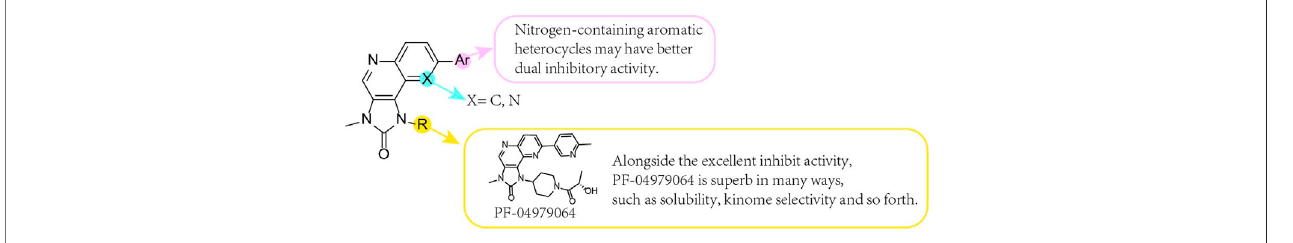
FIGURE 6 | SAR of imidazonaphthyridone core